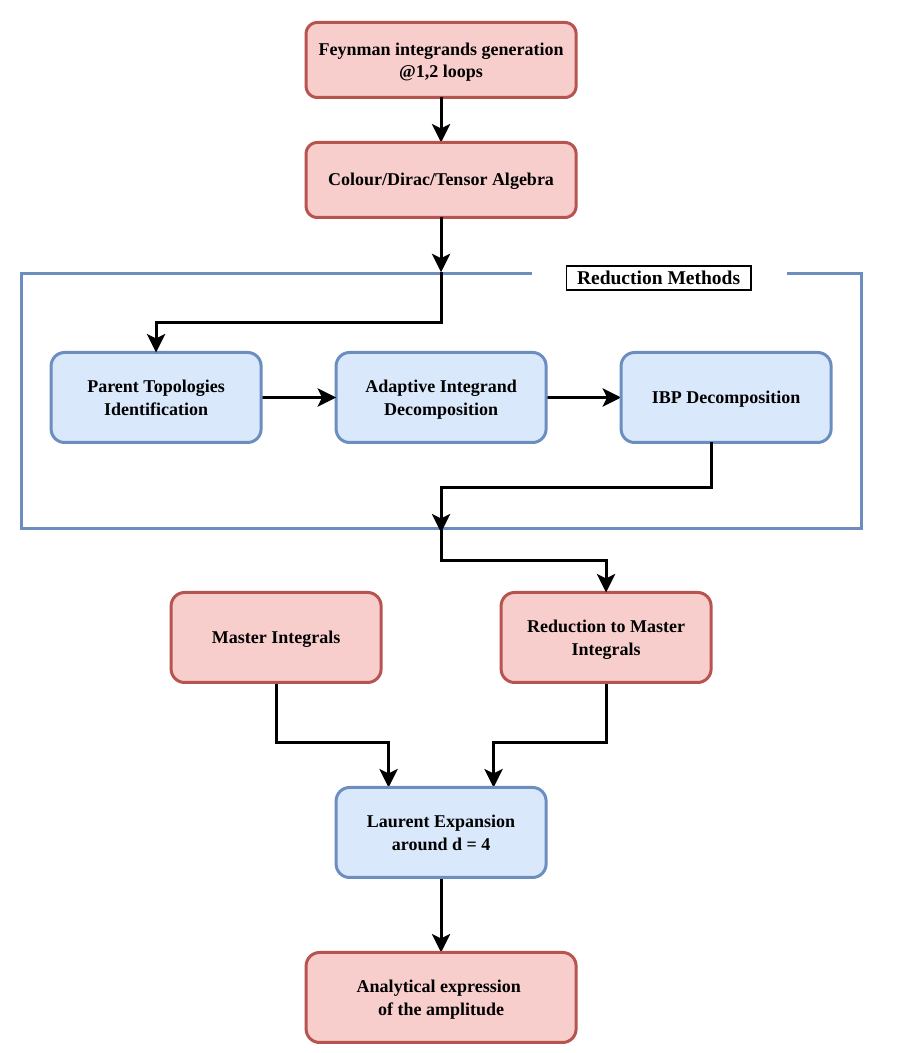
Figure 9 . Flow-chart of the Aida